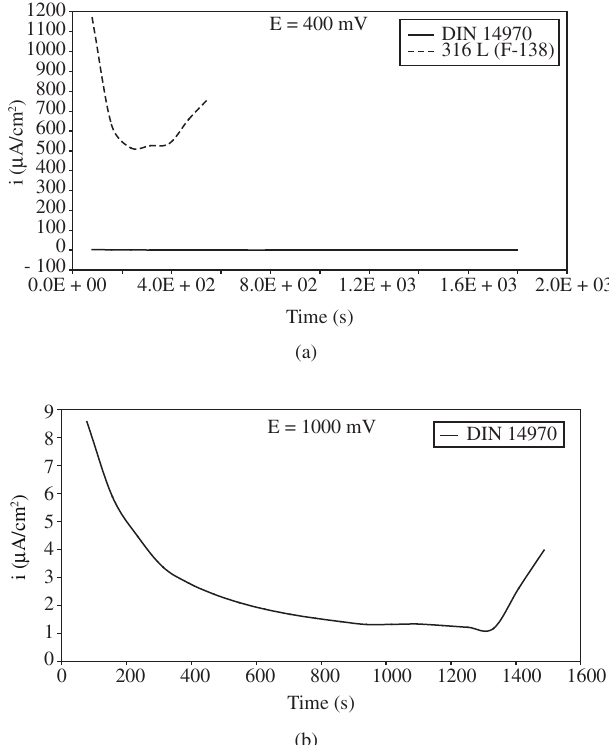
Figure 5. Potentiostatic polarization curves for ASTM F-138 and DIN W. Nr. 1.4970 stainless steels a) E = 400mV; and b) E = 1000